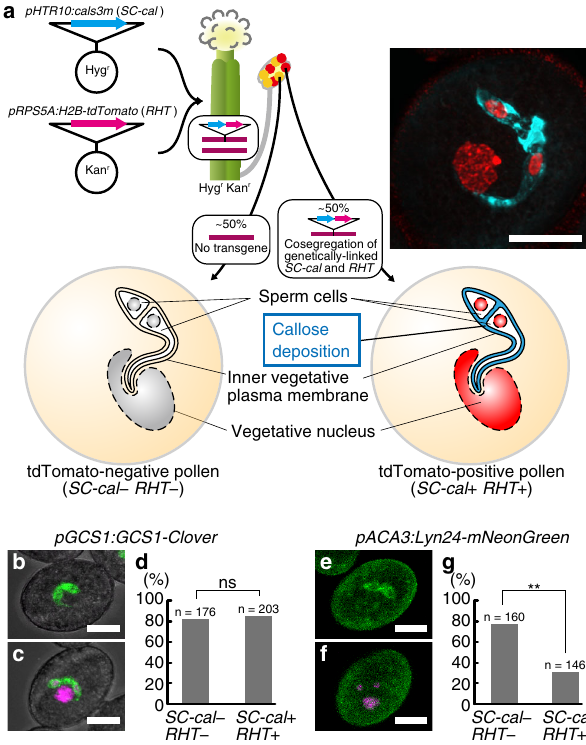
Fig. 2 Callose accumulation causes severe defect in sperm cell migration. cell-speci fi c pGCS1:GCS1-Clover reporter gene in the SC-cal RHT hemizygous plant. The percentages of Clover-labeled sperm cells in tdTomato-negative pollen ( SC-cal − RHT − , b ) and tdTomato-positive pollen ( SC-cal + RHT + , c ) are shown in ( d ). P = 0.76. e – g Localization of an inner vegetative plasma membrane marker protein, Lyn24-mNeonGreen, in the pollen from a SC-cal RHT hemizygous plant. Percentages of eyeglass-shaped mNeonGreen signal in tdTomato-negative pollen ( SC-cal − RHT − , e ) and tdTomato- positive pollen ( SC-cal + RHT + , f ) are shown in ( g ). P = 4.04×10 − 8 . Scale bar: 10 μ m. Asterisks, signi fi cance by Pearson ’ s chi-square test. ns, not signi fi cant.